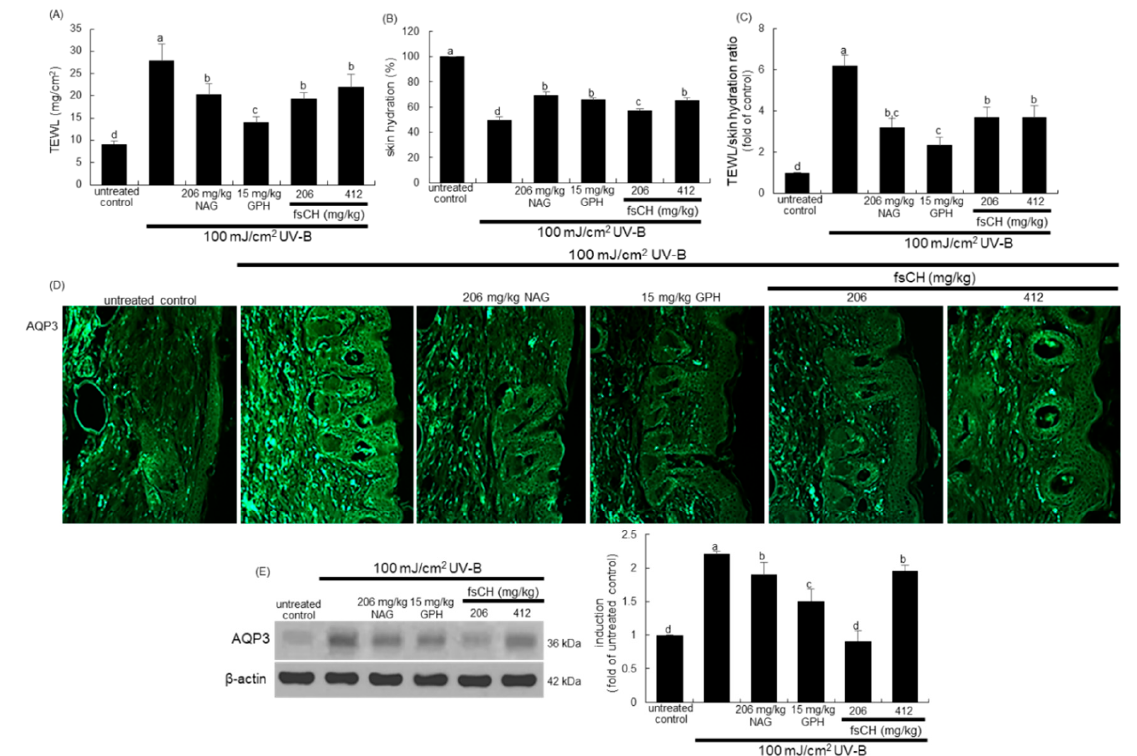
Figure 8. Effects of Pangasius hypophthalmus fish skin hydrolysates (fsCH) on transepidermal water loss (TEWL), skin hydration, and aquaporin 3 (AQP3) level in ultraviolet-B (UV-B) radiation-exposed mice. SKH-1 hairless mice were exposed to UV-B radiation three times a week and treated with 206 mg/kg N-acetyl-D-glucosamine (NAG), 15 mg/kg glycine-proline-hydroxyproline tripeptide (GPH), and 206–412 mg/kg fsCH orally for eight weeks. TEWL ( A ), skin hydration ( B ), and TEWL/skin hydration ratio ( C ) were measured and calculated. The AQP3 level of skin tissues was immunohistochemically confirmed by FITC-green staining ( D ). Skin tissue extracts were electrophoresed on 10% SDS-PAGE and subjected to Western blot analysis with a primary antibody against AQP3 ( E ). β -Actin antibody was used as an internal control. The bar graph (mean ± SEM, n = 3) in the right panel represents the quantitative results of blot band on the left obtained from a densitometer. Respective values in bar graphs not sharing a small letter are different at p < 0.05.